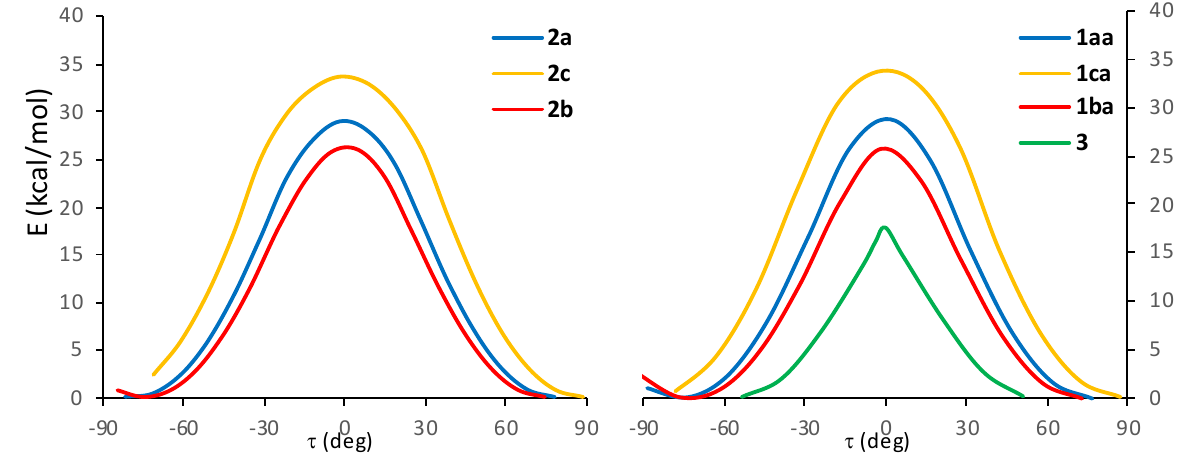
Figure 3. Relaxed scan along the racemization interconversion path obtained at M06-2X/6-31+g(d,p). Dihedral angle τ is defined in Figure S1. In the case of compounds presenting phenyl pendant groups, the curve is the minimal path of a double scan obtained by also relaxing the phenyl orientation with respect to the helicene backbone (see